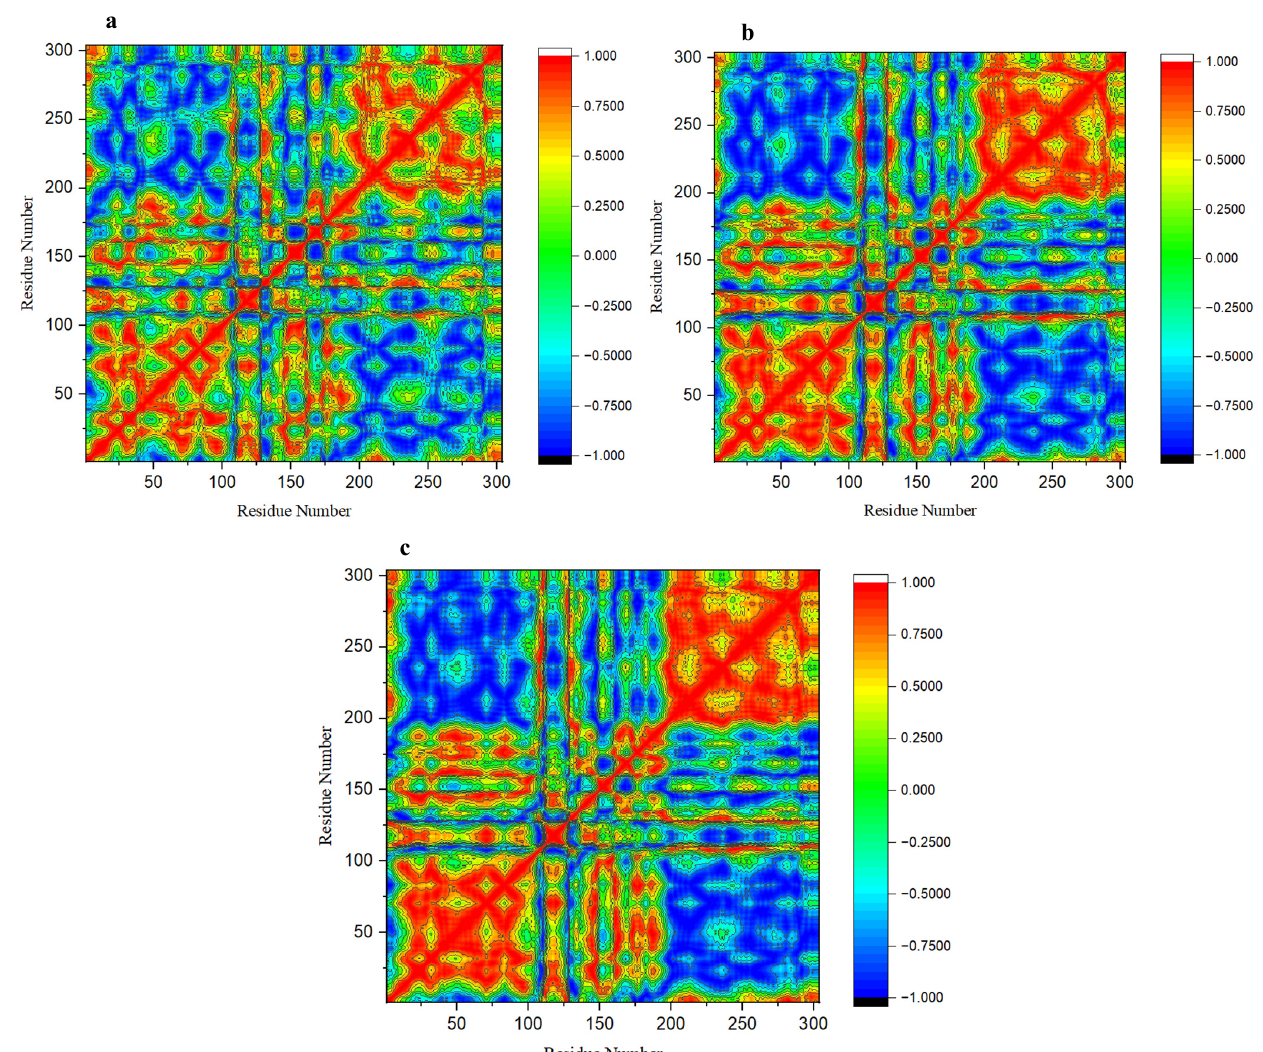
Figure 5. DCCM plot of the alpha carbon fluctuations for the 600 ns simulation period: ( a ) 3CLpro apo-protein; ( b ) 3CLpro–CS1 complex; ( c ) 3CLpro–CS2 complex.